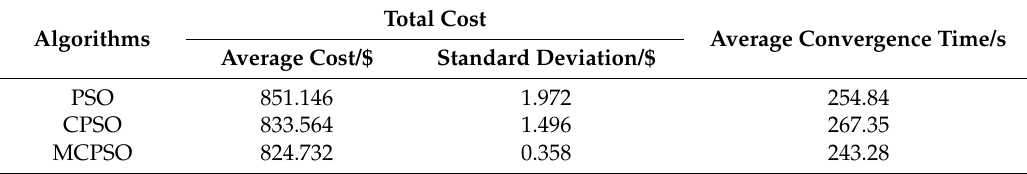
Table 4. Statistics of different algorithms’ 20 operating results.